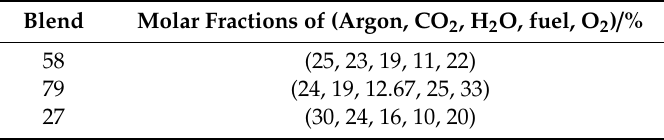
Table 1. Compositions of the blends (blend number as in